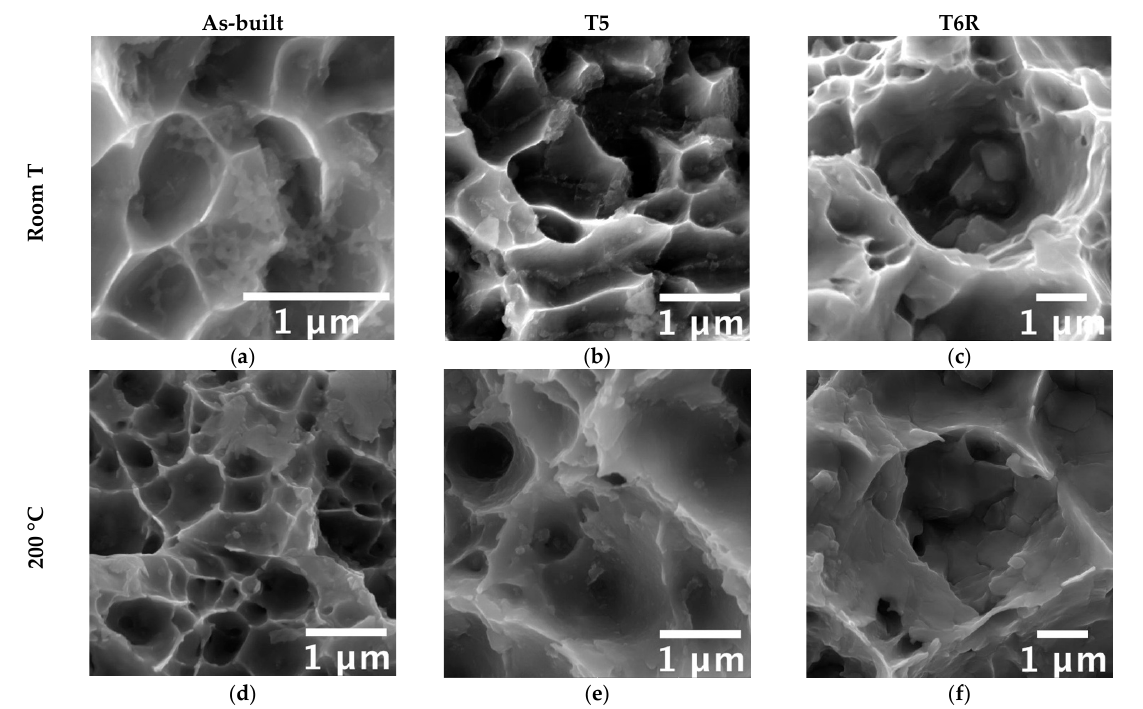
Figure 13. FEG-SEM high magnification fractographic analyses of AB, T5, and T6R AlSi7Mg PBF- LB tensile samples after ( a – c ) tests performed at room temperature; ( d – f ) tests performed at high temperature (200 °C).